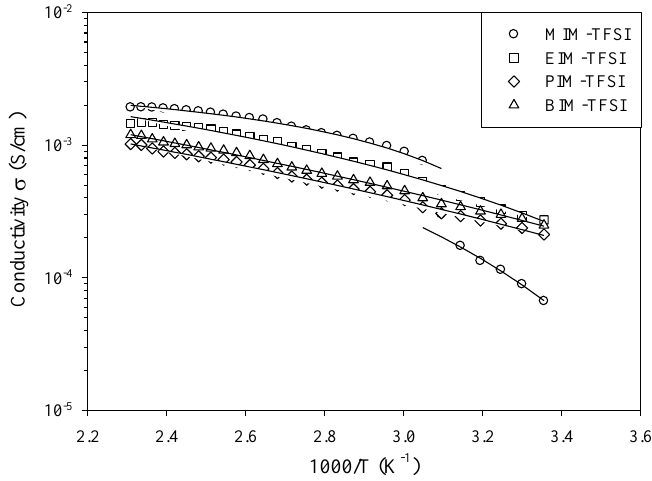
Figure 10. Temperature dependence of the conductivity of the composite Matrimid ® / PIL membranes. Solid lines are the best fit of the VFT (Equation (4)) equation.